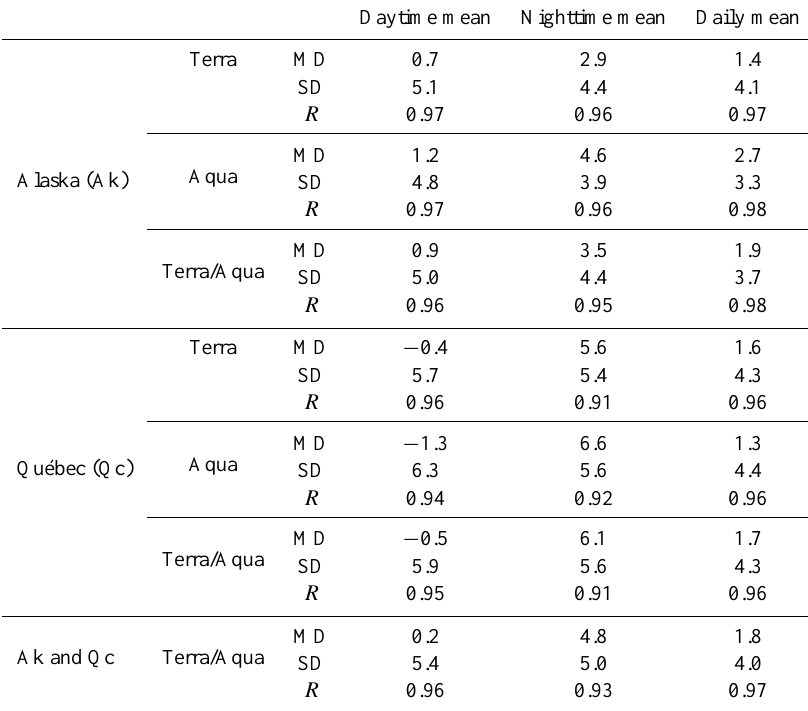
Table 7. Mean Difference (MD), Standard Deviation (SD) and Correlation ( R ) between T air and LST for daytime, nighttime and daily average from Aqua and Terra separately, and Aqua/Terra